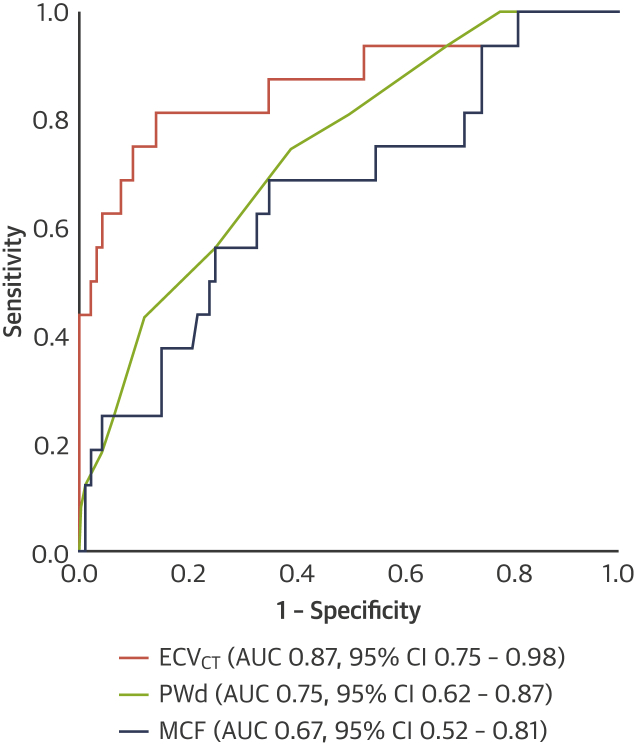
Receiver-Operating Characteristic Curve for the Detection of Any Cardiac Amyloid (DPD Perugini Grade 1 or 2) Using ECVCT With a 3-Min Post-Contrast Acquisition, PWd, and MCFThe voltage/mass ratio was not included because this approach would have excluded nearly one-third of patients (32 in total) due to bundle branch block or ventricular paced rhythm. AUC = area under the curve; CI = confidence interval; MCF = myocardial contraction fraction; PWd = posterior wall diameter; other abbreviations as in Figure 1.